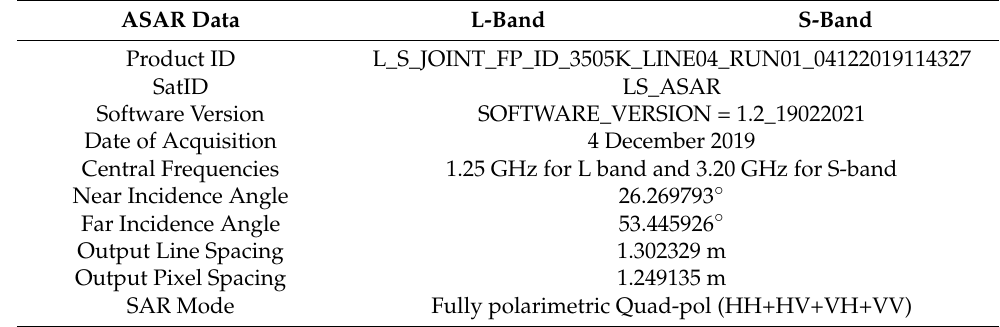
Figure 1. The presence of five 4.8-m corner reflectors (CRs) in HH-polarisation of ( a ) L-band and ( b ) S-band SAR images. Table 1. A description of ASAR data.